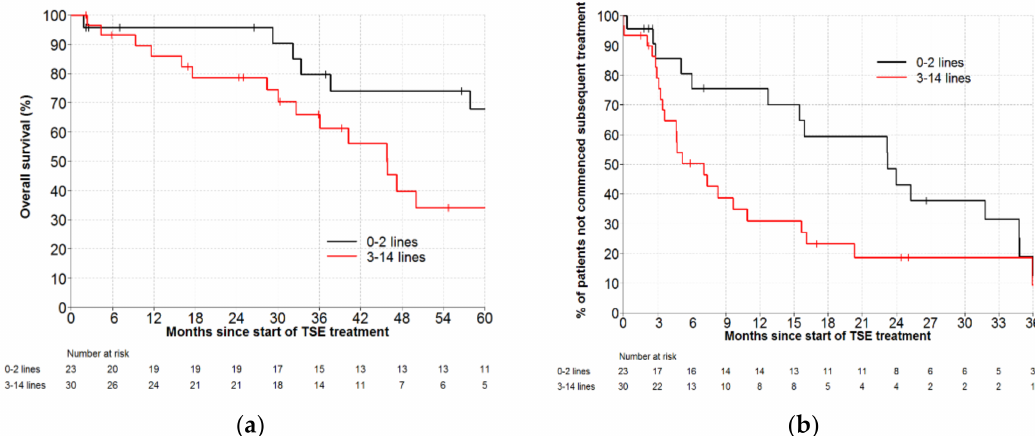
Figure 3. ( a ) Overall survival by number of previous lines of therapy in patients treated with conventional-dose total skin electron therapy (TSE) for mycosis fungoides, HR per additional line of treatment = 1.19 (95% CI: 1.06–1.35, p = 0.005). ( b ) Time to next treatment by number of previous lines of therapy in patients treated with conventional-dose total skin electron therapy (TSE) for mycosis fungoides, HR per additional previous line of treatment = 1.13 (95% CI: 1.01–1.27, p =